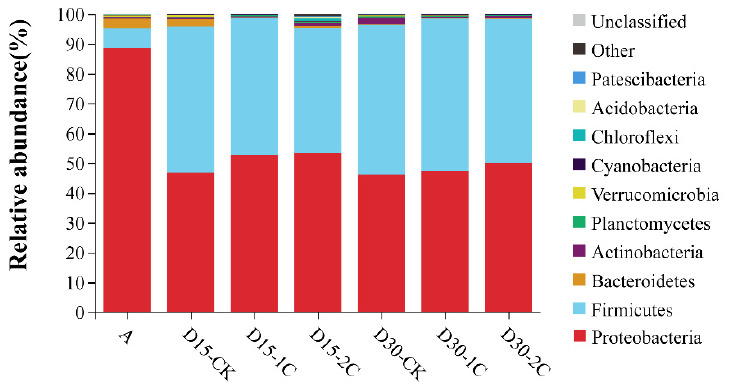
Figure 1. Microbial community and relative abundance by phylum for alfalfa silage (A, fresh alfalfa; CK, the control; 1C, 1% biochar; 2C, 2% biochar; D15, D30, after 15, 30 days ensiling, respectively).